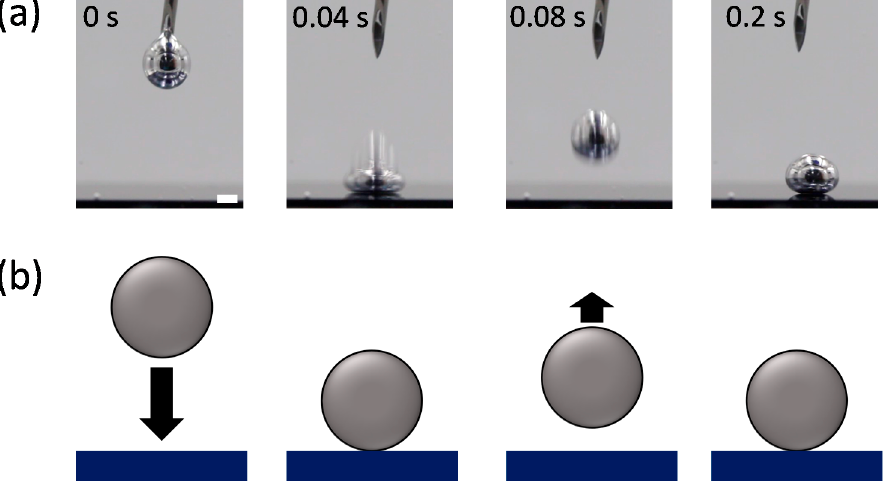
Figure 3. ( a ) Video snapshots of the EGaIn droplet impacting a Si wafer in water at 20 °C. Scale bar is 2 mm. ( b ) Schematic of the “bouncing” behavior of the EGaIn droplet in ( a ).